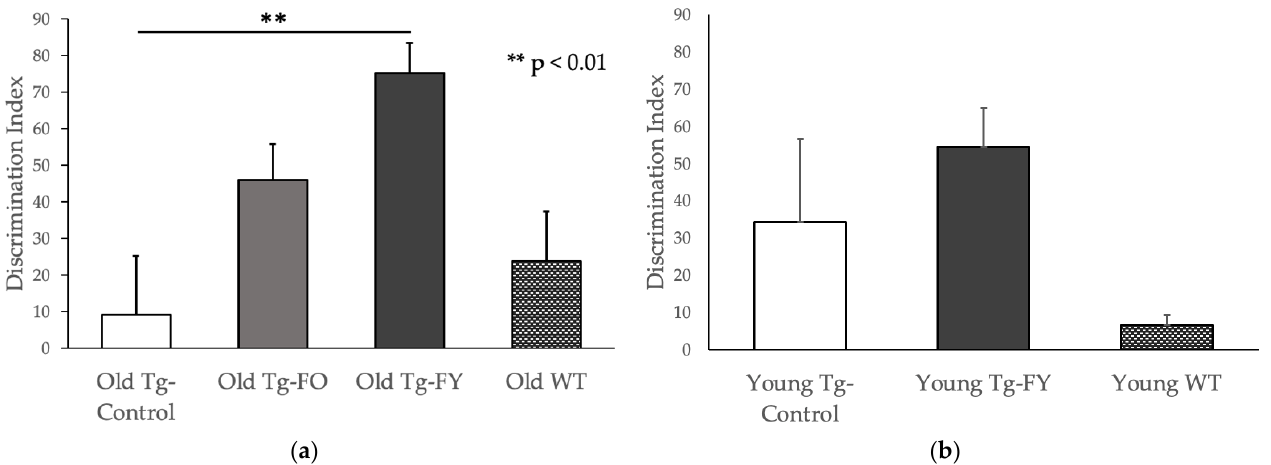
Figure 3. FMT treated mice show improved recognition and spatial memory levels in Novel Object Recognition test measured using Discrimination Index (DI). ( a ) Old Tg-FO ( n = 8) and Old Tg-FY ( n = 8) had increased Discrimination Index (Old Tg-FY p < 0.01 compared to Old Tg-Control ( n = 7)). ( b ) Young Tg-FY also showed improved DI compared to Young Tg-Control ( n = 8). WT values are presented for comparison only. Data is presented as mean ± SEM. Young Tg-FY: Young Transgenic- Fed Young, Young Tg-Control: Young Transgenic Control, Old Tg-FY: Old Transgenic-Fed Young, Old Tg-FO: Old Transgenic-Fed Old, Old Tg-Control: Old Transgenic Control, Young WT: Young Wildtype, Old WT: Old